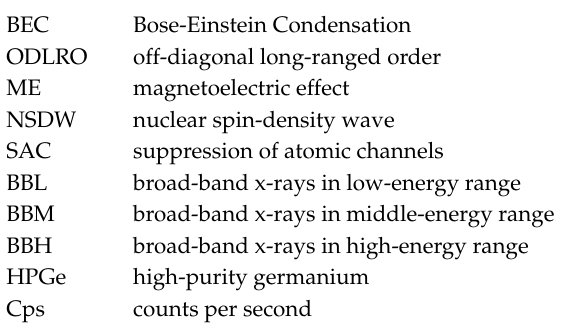
Figure S2: γ counts of the first monitoring experiment in Figure S1; Figure S3: Spectra of Figure S1, Figure S5, and calibration; Figure S4: 182 Ta γ count rates; Figure S5: Raw data of the second 40-day monitoring experiment; Figure S6: Data in Figure S5 incorporating the hourly smoothing (61 data); Figure S7: γ counts of the second monitoring